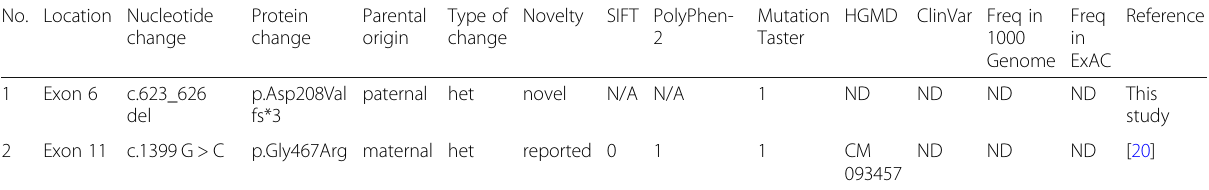
Table 2 Analysis and in silico prediction of the ETFDH gene variants of the infant No. Location Nucleotide